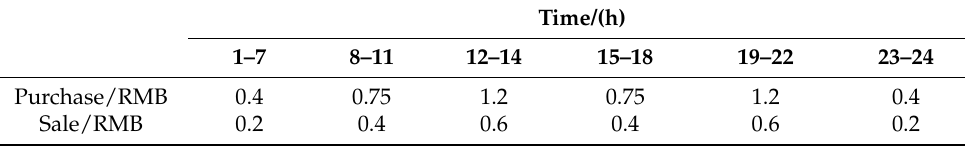
Table 2. Purchase and sale price of the power grid.